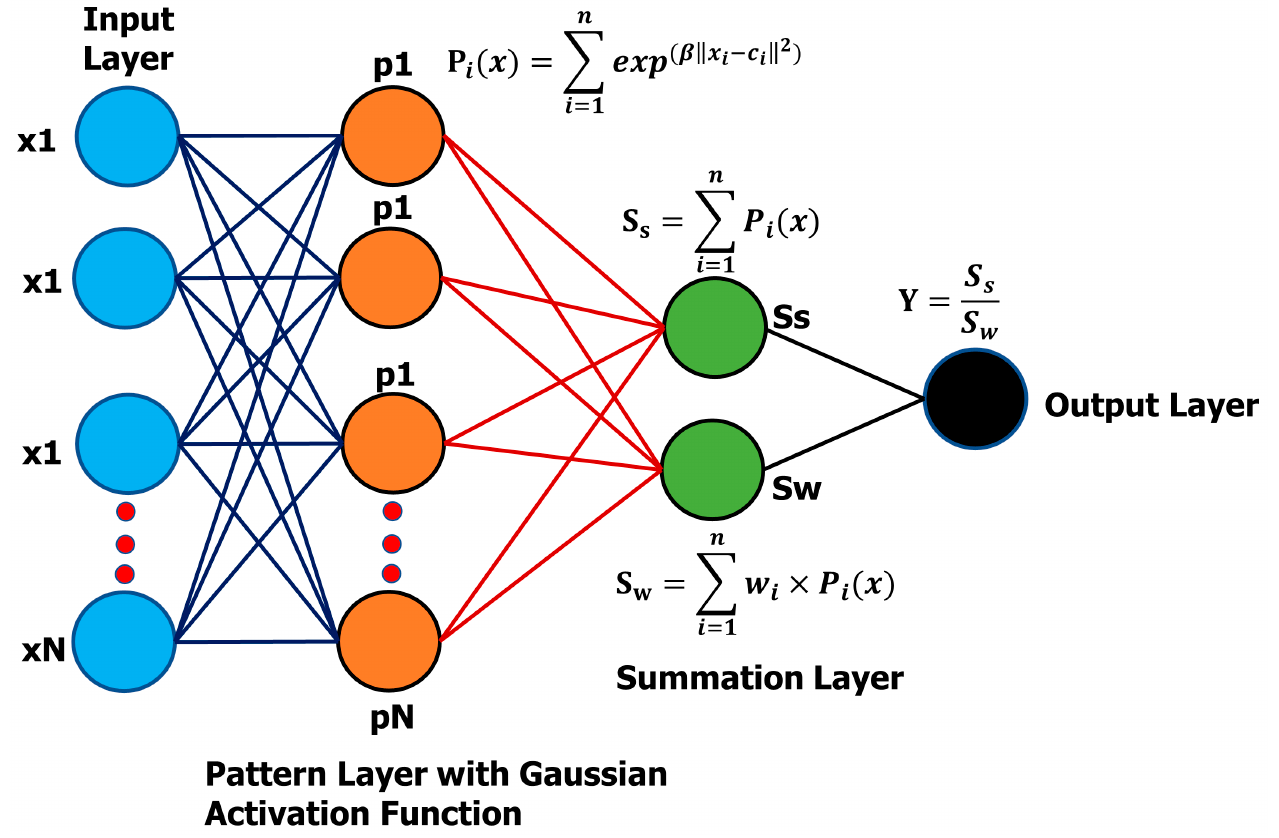
Figure 6. Structure of GRNN consisting of hidden layers.